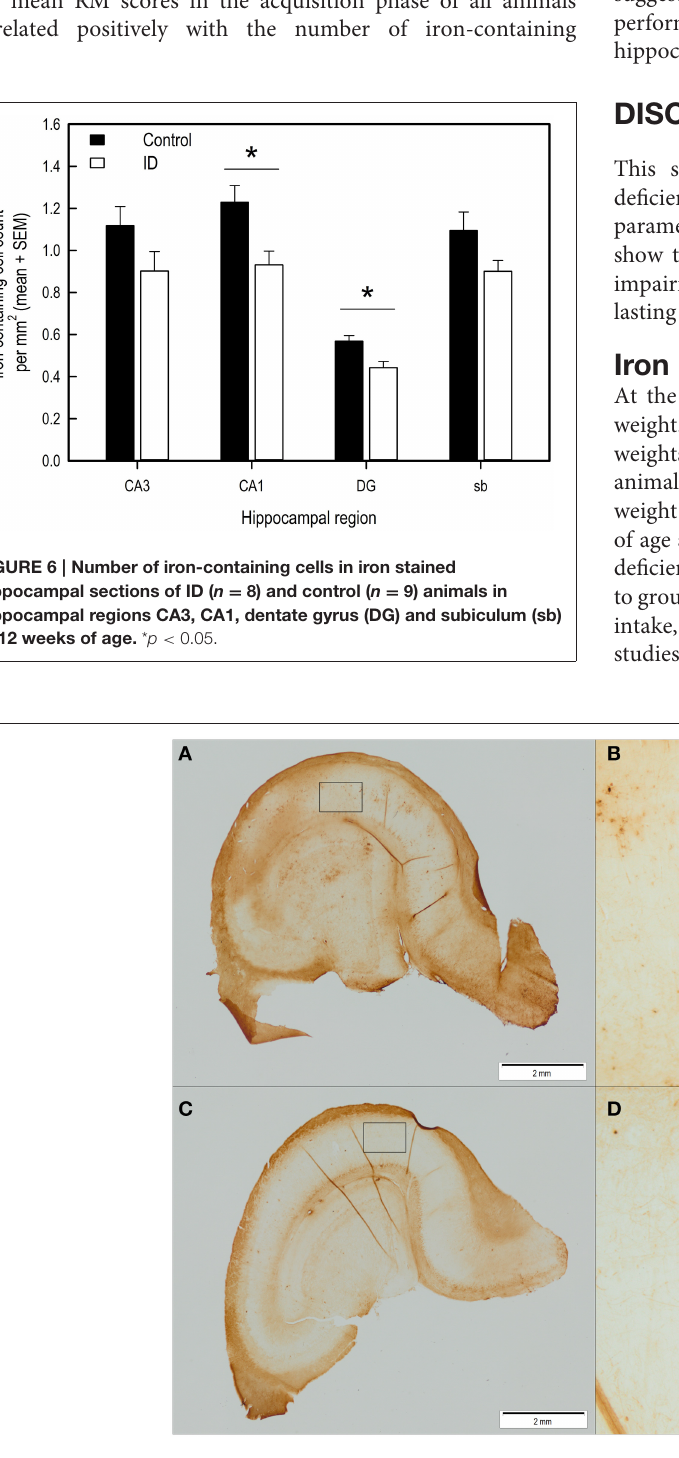
Frontiers in Behavioral Neuroscience |